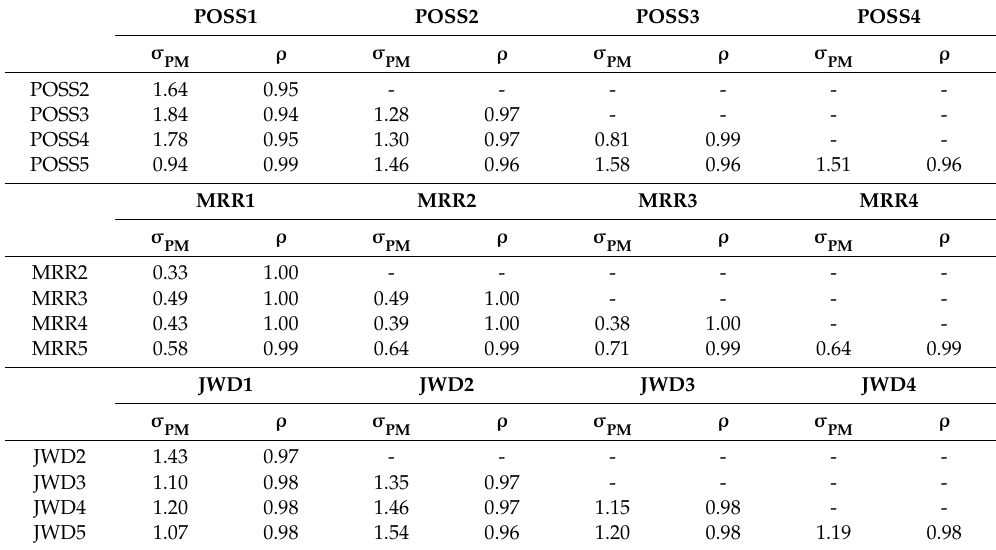
Table 6. The measurement error ( σ ) and the correlation coe ffi cient ( ρ ) of reflectivity (Z) from paired PM measurements of POSS, MRR and